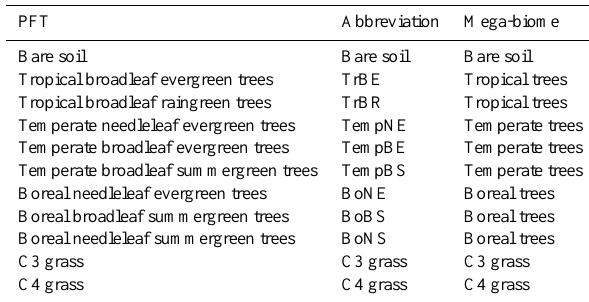
Table 1. Plant functional types (PFT) in ORCHIDEE, abbreviation used and mega-biome assignment in this